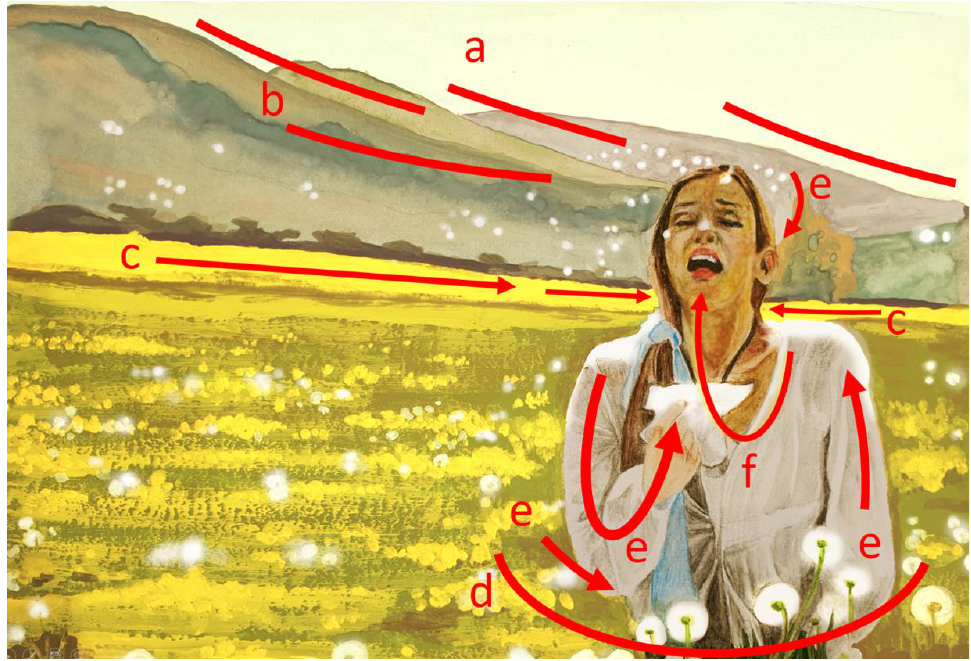
Figure 2. Formal analysis of the most frequently used picture in advertisements of allergy-related products and services depicting plants. The picture represents a popular design concept in visual marketing in allergies. Red arrows, lines and shapes are tools of formal analysis, showing how the viewer’s eyes are led by major elements and design principles (underlined in the text below ) of the picture to the central figure (patient) and affected organs (mouth and nose). Note that the predominant color of the flowers in both images is yellow. The picture depicts a woman standing on a dandelion ( Taraxacum officinale ) field. The negative space (represented by herbaceous weed population) is large, homogenous, colorful and contrasting to the patient. The plants’ airborne cypselae fruits and sneezing suggests a causal relationship between the plant and the allergic reaction. The viewer’s eye is led by the lines of hills (a,b) as well as by colors, values and contrasts of the vegetation (c,d) to the central figure, whose movements (e,f) express a strong allergic reaction. The viewer’s impression (i.e., the e ffect of the artwork) is that the patient is ‘sinking into’ a field of allergenic weeds while sneezing and wheezing. The current picture (aquarelle painting) is made by the author (Donát Magyar) to represent the design of the original photograph [21].